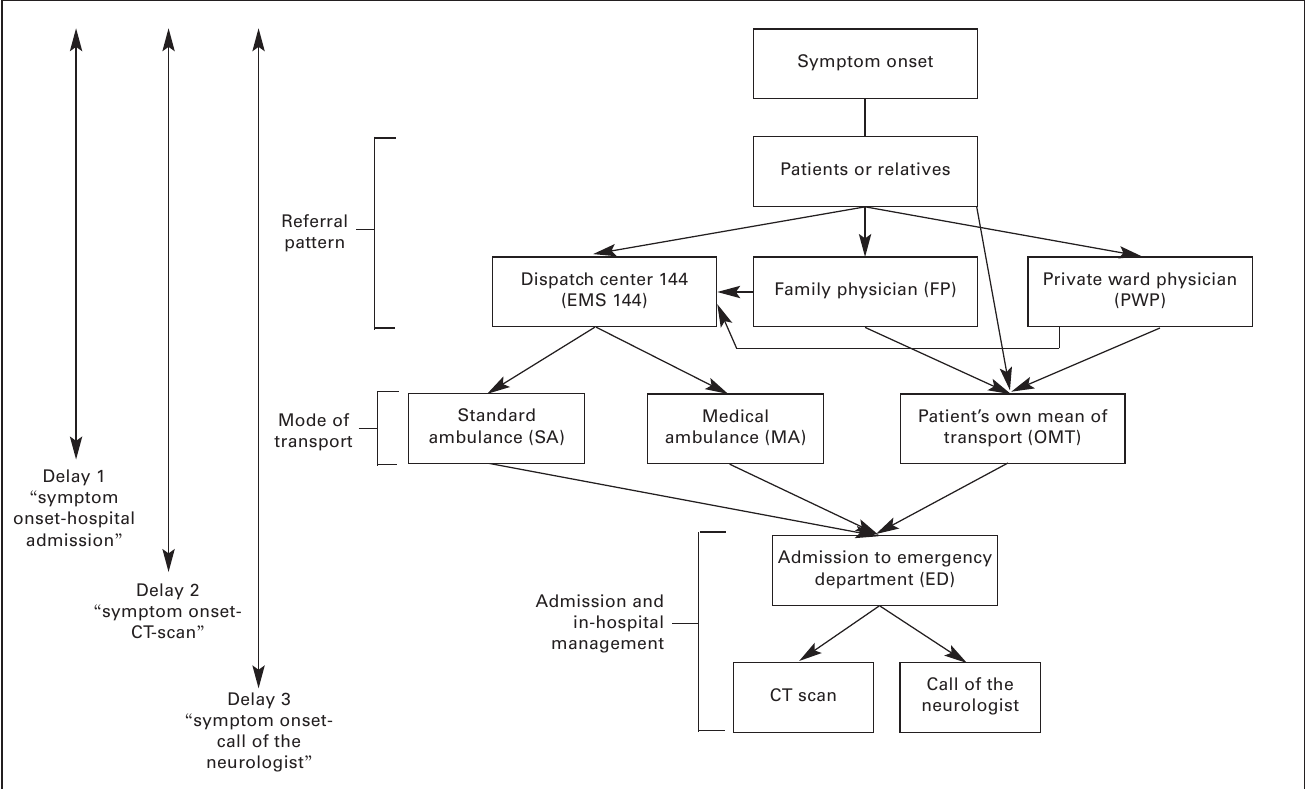
Diagram of pre- and early in-hospital delays according to the different pathways used from onset of symptoms until admission to the emergency